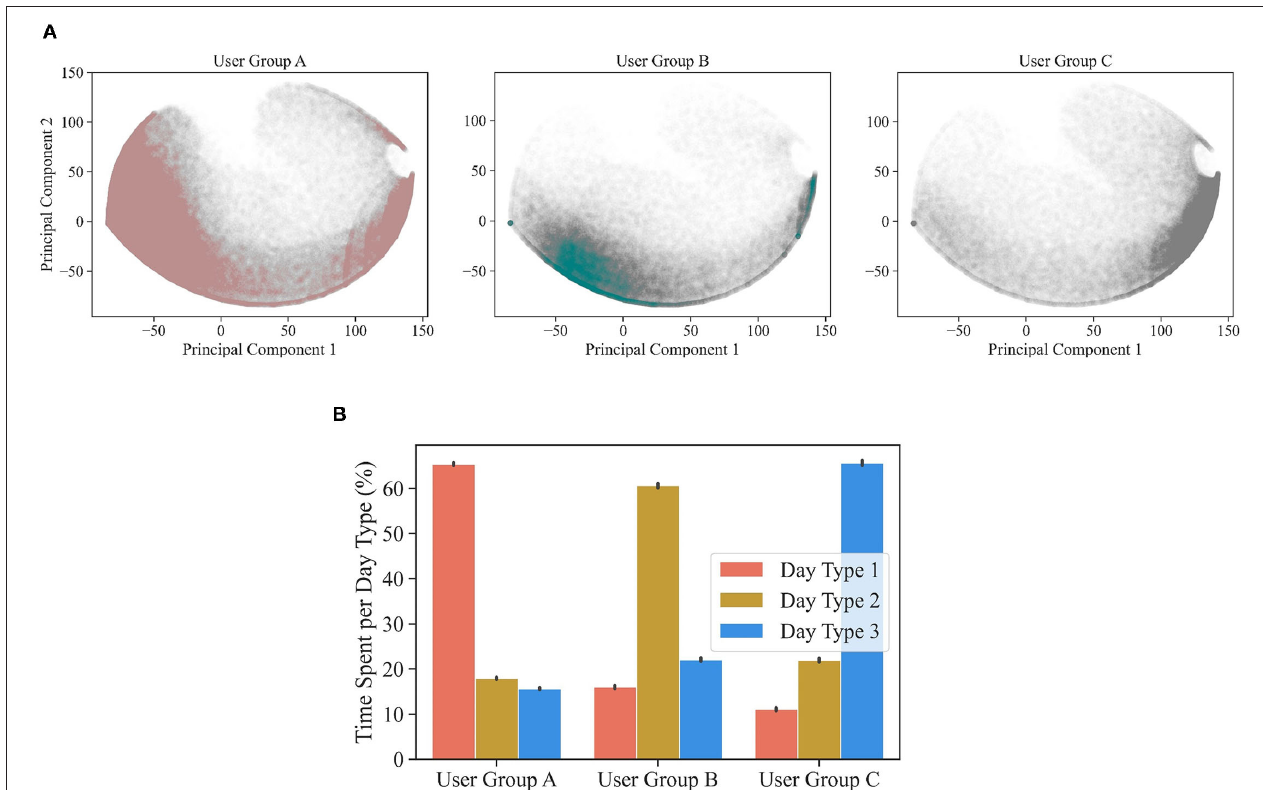
FIGURE 7 | In (A) , for each of the three user clusters (i.e., user group A, B, and C), the days of HA use are displayed as scatter plot against the two main principal components. The distinct densities indicate that the three user groups experienced substantially different days of HA use. In (B) , the average proportion of time spent ( ± 95% confidence interval) in each day type is displayed for each user cluster.